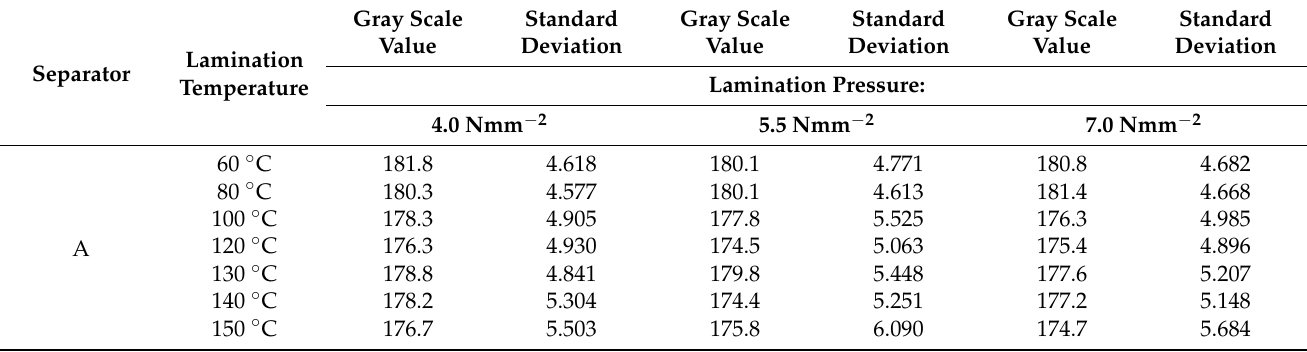
Table A1. Grey scale values of the surface of separator A (nonwoven separator impregnated with ceramic particles), separator B (membrane-based monolayer) and C (membrane-based trilayer) assigned to different lamination temperature and pressure combinations (F c